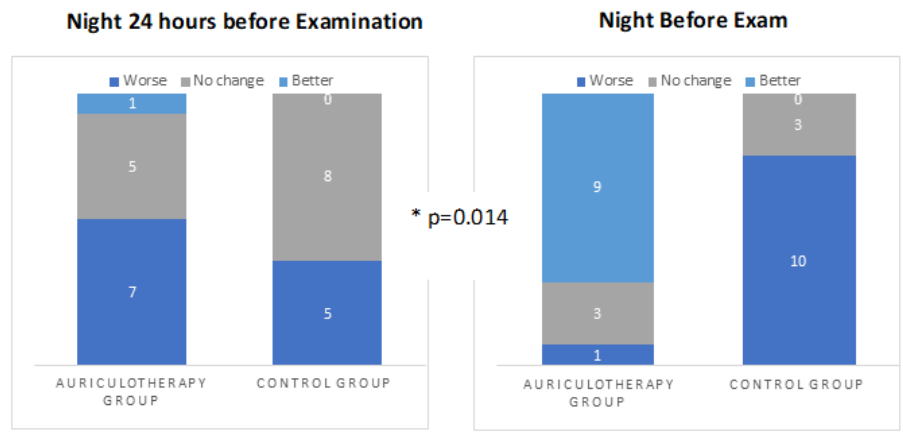
Figure 8. Simple bar chart summaries of separate variables by sleep Figure 8. Simple Bar chart summaries of separate variables by sleep quality.